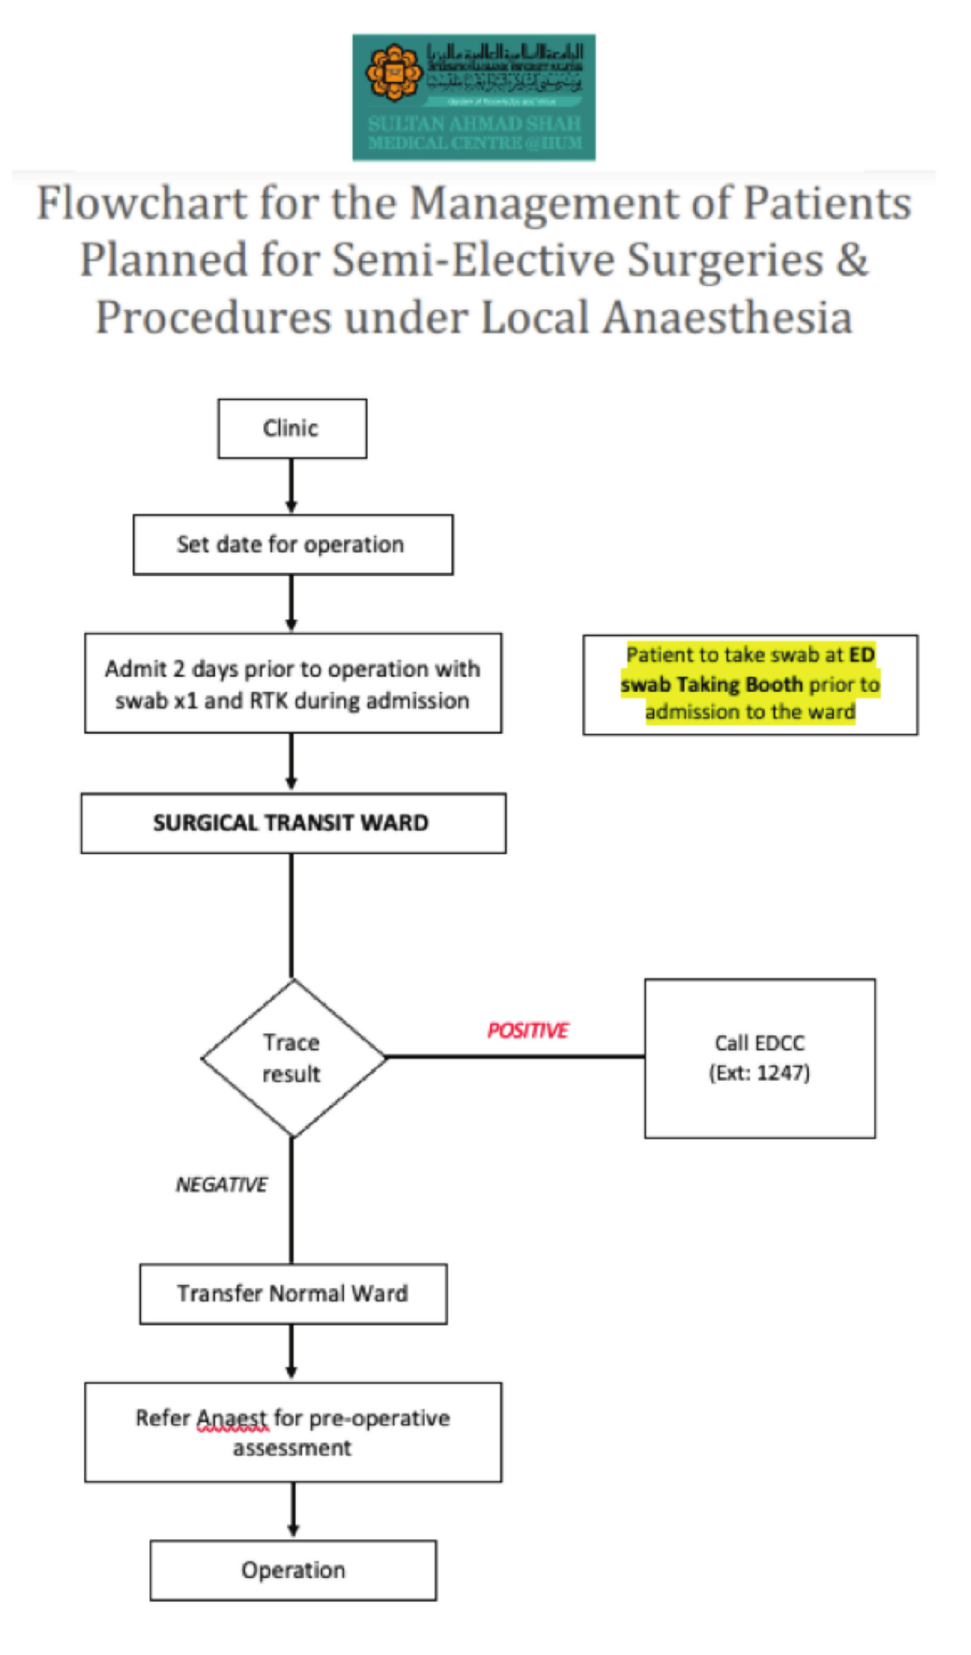
Flowchart for the management of patients planned for semi-elective surgeries & procedures under local anaesthesia at Sultan Fig. 8: Ahmad Shah Medical Centre